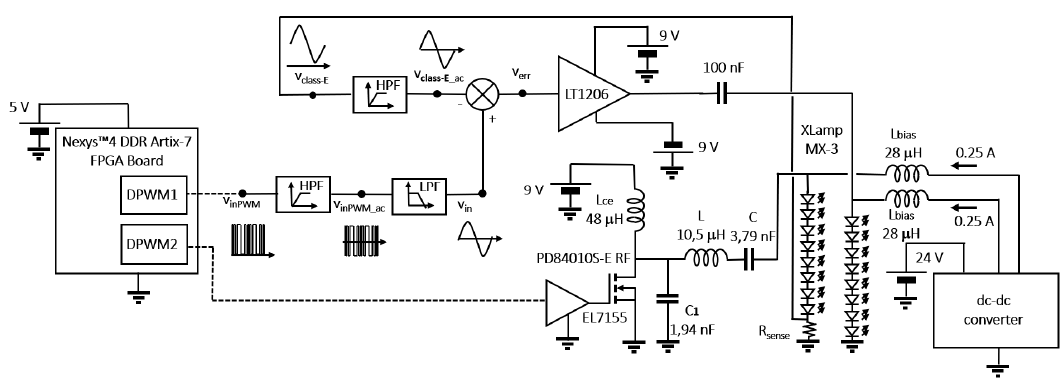
Figure 13. Experimental setup of the adaptation of the linear-assisted technique for a Class E RFPA.